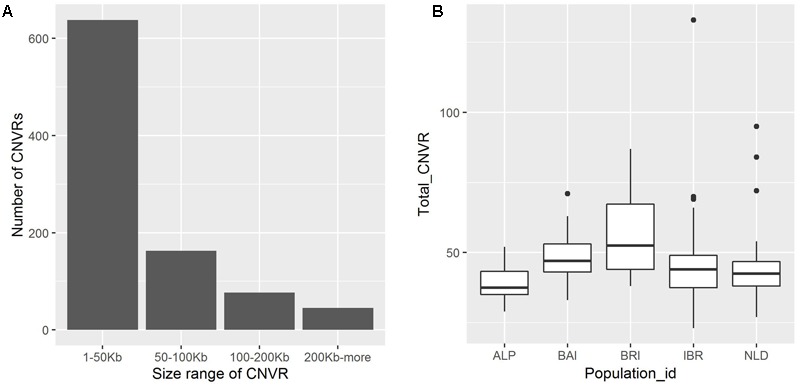
(A) Distribution of CNVR size in the genome. (B) Distribution of CNVR per sample categorized based on its origin. The median of the population is indicated by central line in a box, while the black dots represents outliers.